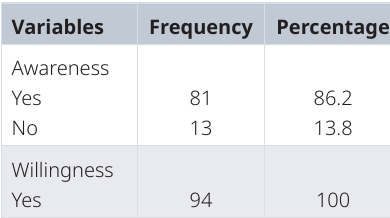
Table 8. Distribution of farmers’ awareness and willingness to cultivate improved varieties.